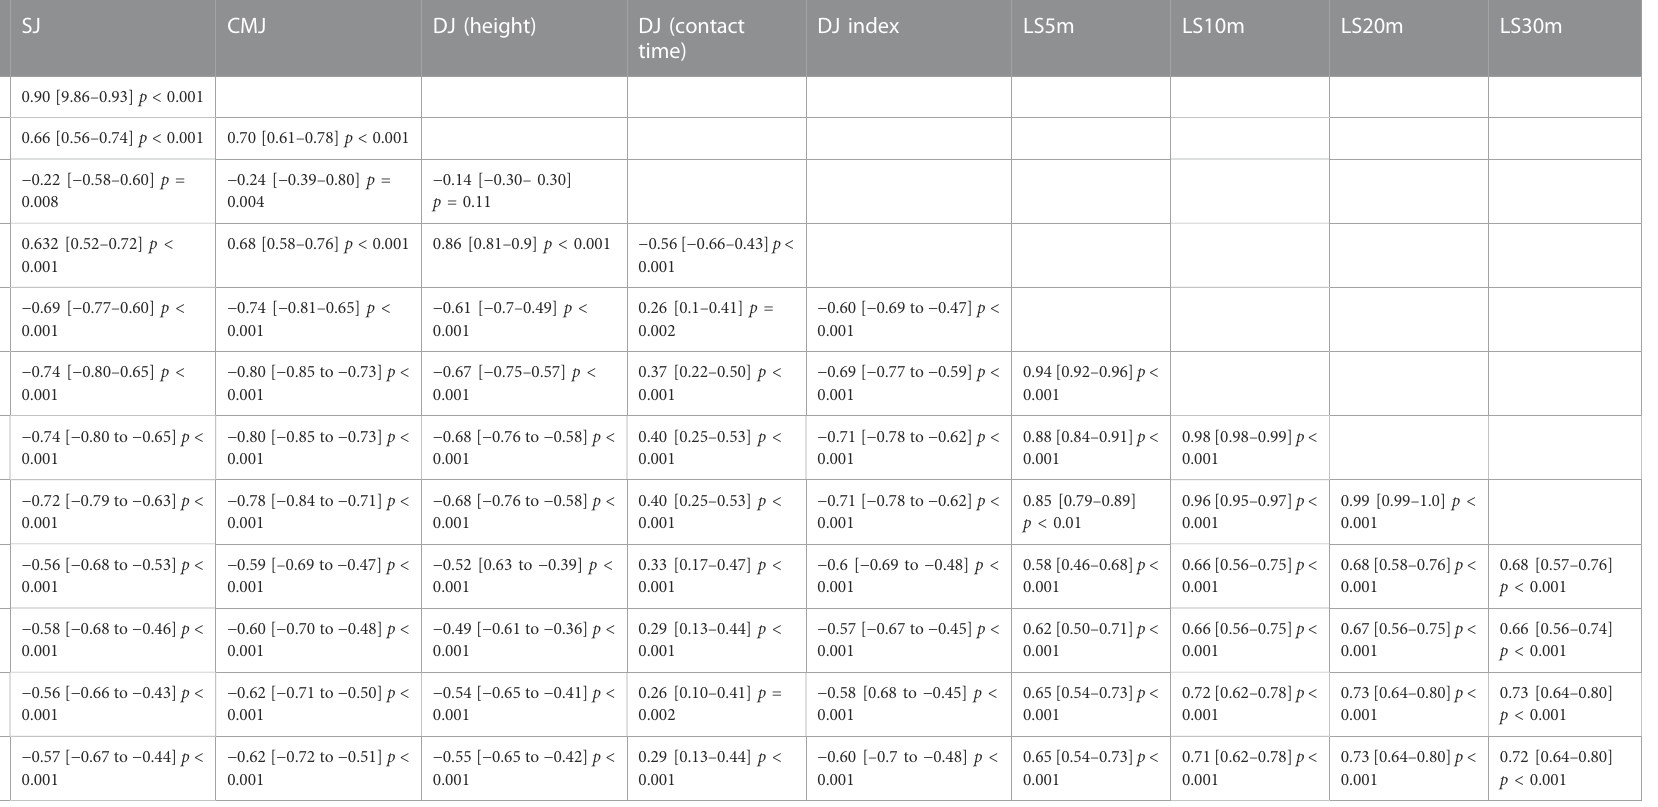
TABLE 3 Correlation matrix for the obtained